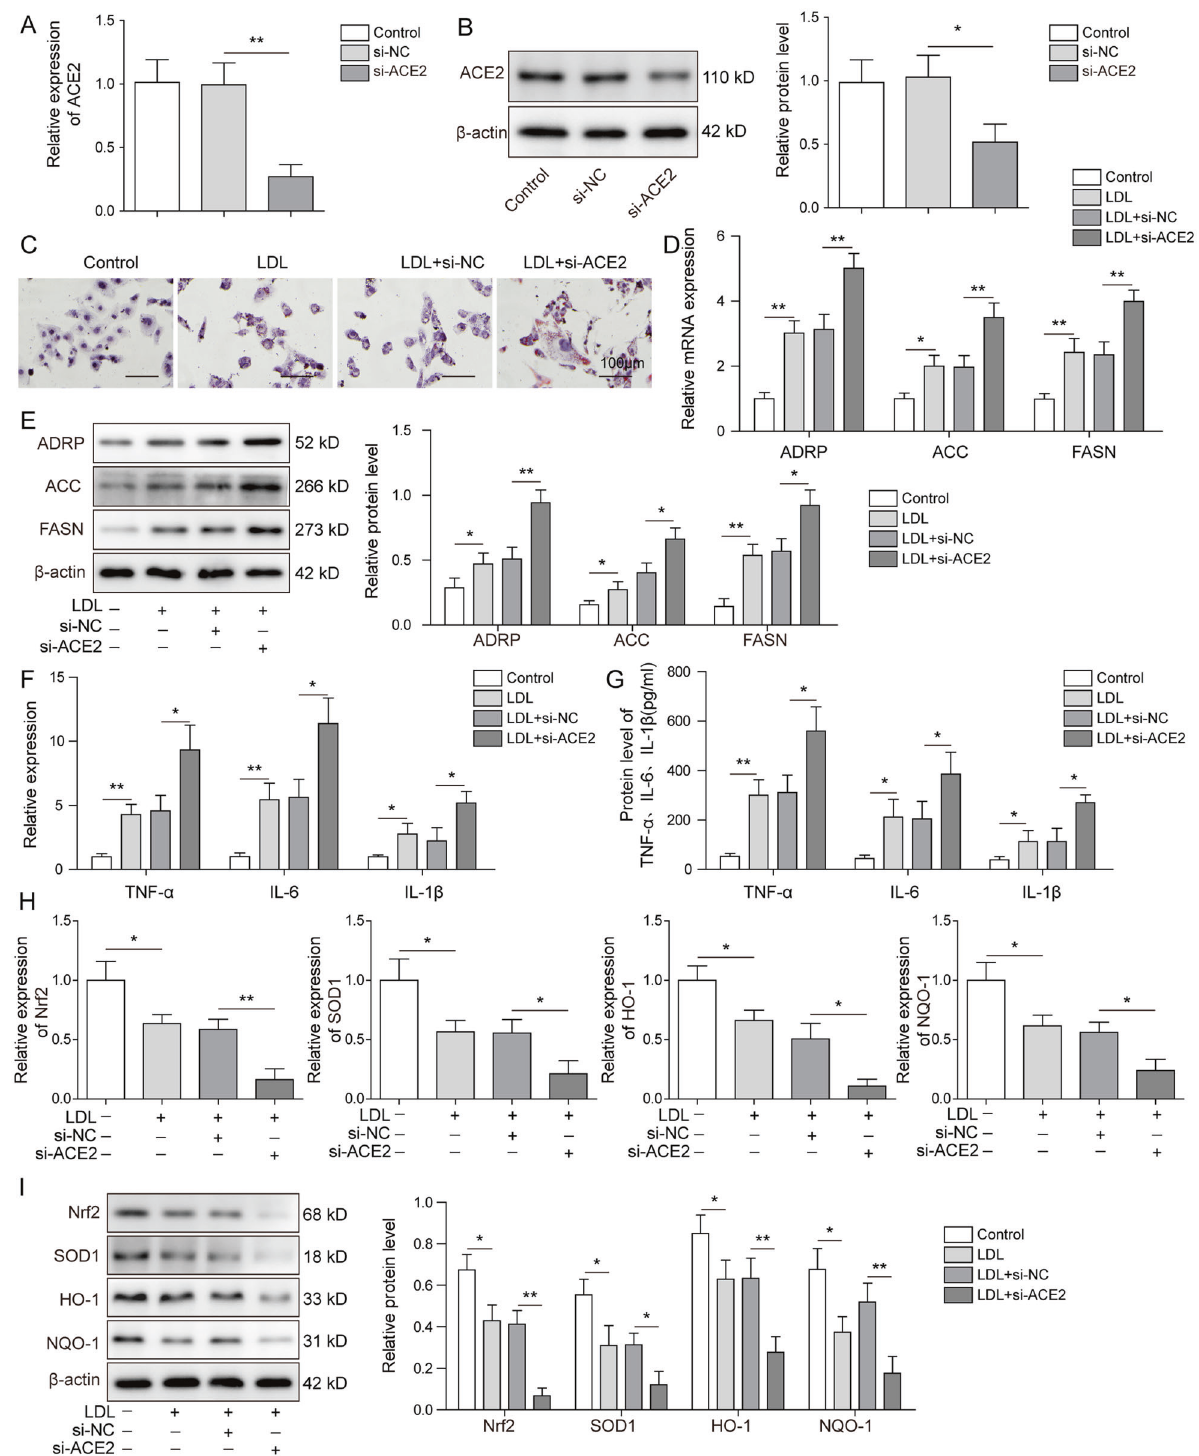
Fig. 4 Lipid deposition and in fl ammatory responses were induced by ACE2 knockdown in mouse renal PTCs. Primary mouse PTCs were generated and lipo-toxicity was introduced by treating the PTCs with ox-LDL. ACE2 expression was silenced by transfecting ox-LDL-treated PTCs with si-ACE2, and transfection ef fi ciency was evaluated by quantifying the ACE2 mRNA ( A ) and protein ( B ) expression. C Cellular lipid droplet formation was visualized by Oil Red O staining. ox-LDL-induced fat droplet formation was further stimulated by si-ACE2 treatment. Cellular lipid synthesis was assessed by detecting the expression of ADRP, ACC and FASN at mRNA ( D ) and protein levels ( E ). Expression pro fi les of the in fl ammatory cytokines were measured at mRNA ( F ) and protein ( G) levels in PTCs. Stable inhibition of ACE2 stimulated expression of TNF- α , IL-6 and IL-1 β compared with the control groups. H , I qRT-PCR and western blot were employed to evaluate the Nrf2 pathway elements including Nrf2, SOD1, HO-1, NQO-1 in the indicated groups. Nrf2 pathway was deactivated by si-ACE2 treatment. Data were representative images or were expressed as the mean ± SD of n = 3 experiments. * P < 0.05, ** P <